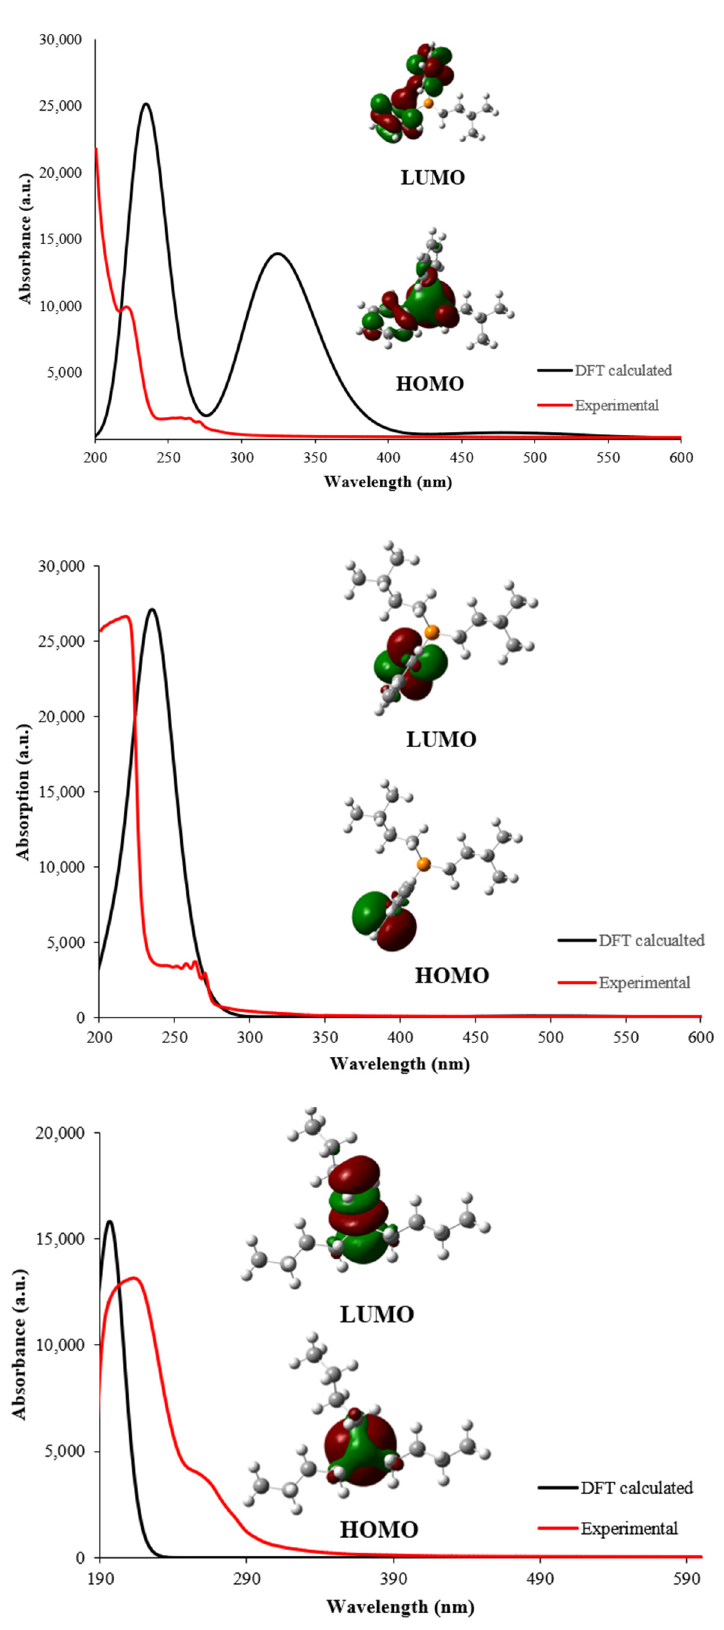
Figure 6. Theoretically calculated (black line) and experimental (red line) UV spectra of ( 5 ), ( 10 ), and tributylphosphine (PBu 3 ) in acetonitrile at room temperature. Frontier molecular orbitals (HOMO/LUMO) are given in the inset.